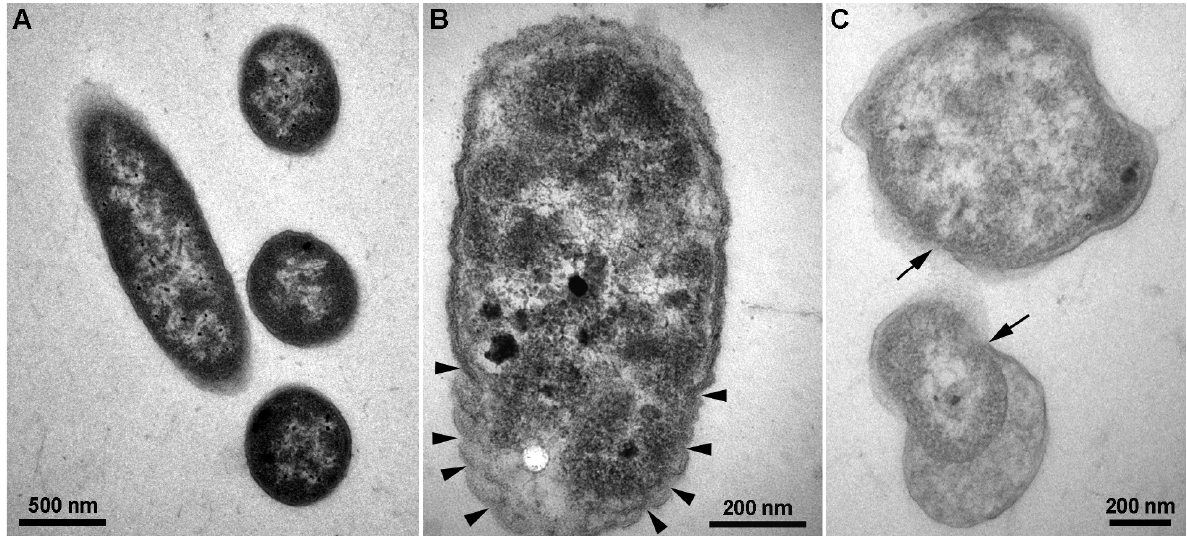
Figure 3. Transmission electron micrographs show cells of Dickeya dadantii CZ 1501. ( A ) Control cells with intact cell envelopes and electron-dense cytoplasm. ( B , C ) Damaged D. dadantii cells with convoluted cell envelopes (arrowheads), breached cell envelopes (arrows), and cleared cytoplasm under the cell-free culture supernatant of Paenibacillus polymyxa ShX301.